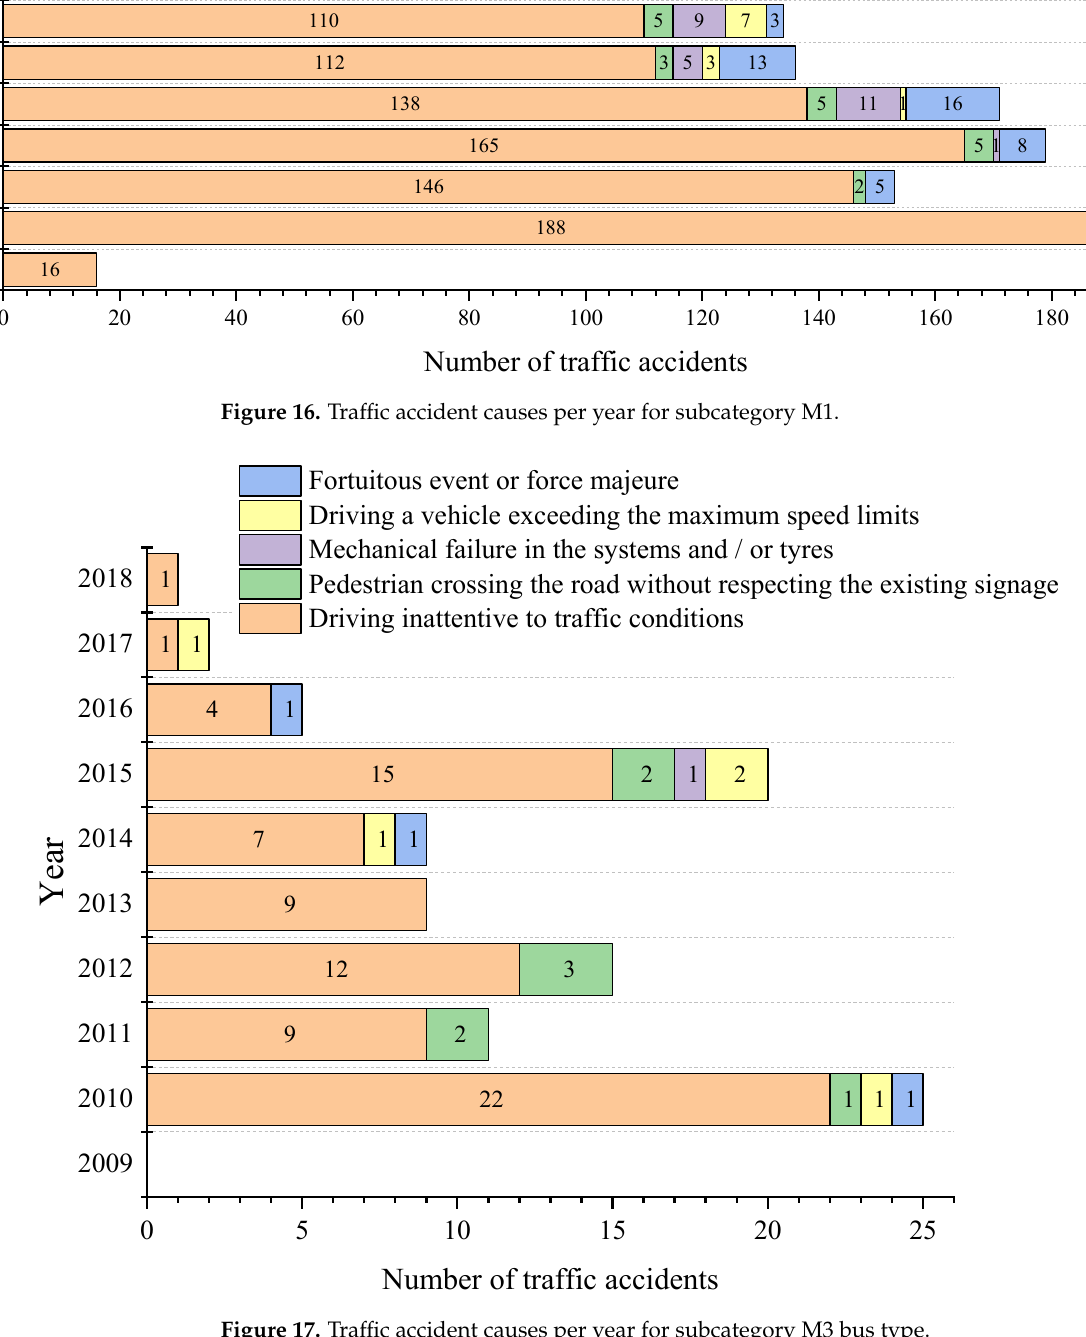
Figure 17. Traffic accident causes per year for subcategory M3 bus type.